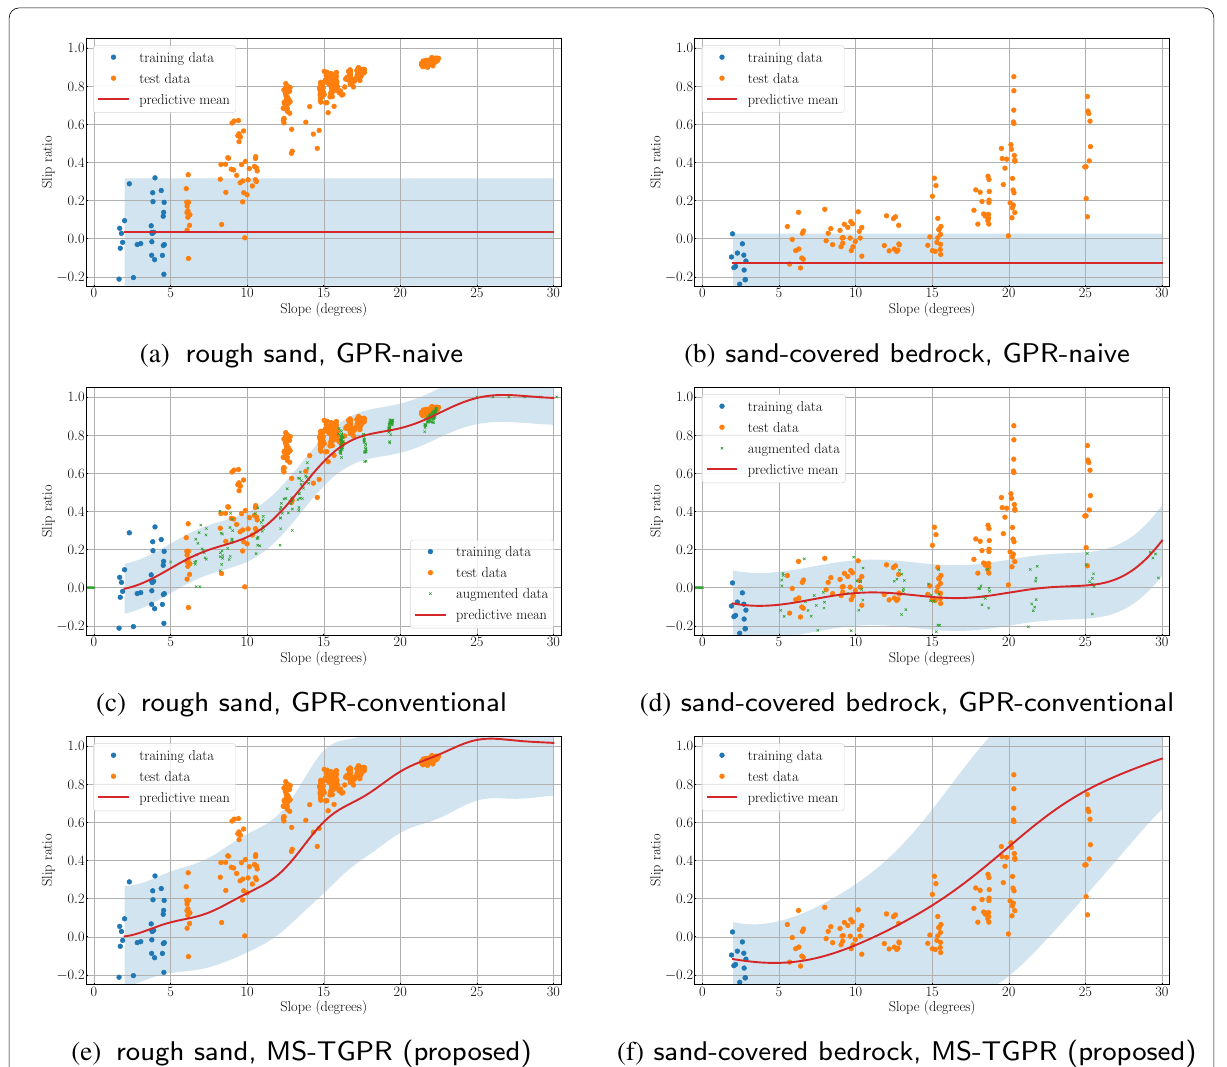
Fig. 8 Results of Evaluation 1. Slip predictions with and without the data transferred from multiple source domains are plotted. The red curve represents the predictive mean while the blue-shaded area represents 2-standard deviation around the mean. The blue and orange points represent the training and test data, respectively. The green crosses in GPR-conventional ((c) and (d)) depict the augmented data from a source